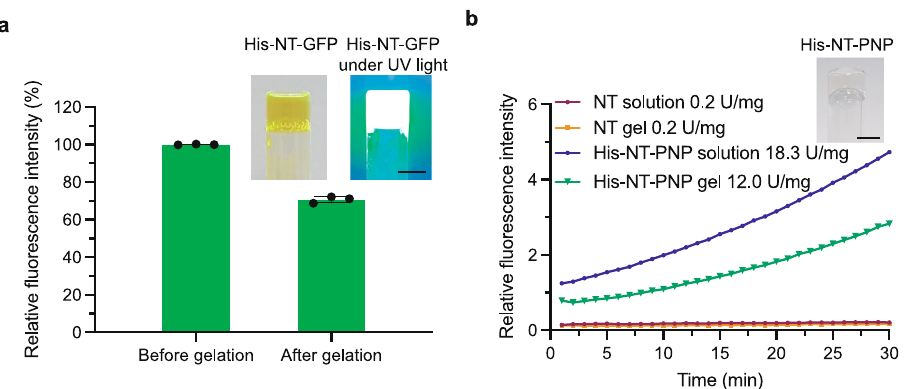
b PNP activity obtained through a fl uorometric assay using a solution and gel, respectively, composed of NT (100mg/ml), and a solution and a gel formed from mixtures containing 0.01mg/ml his-NT-PNP and 100mg/ml NT. Insert shows an inverted vial with a His-NT-PNP containing hydrogel (scale bars are